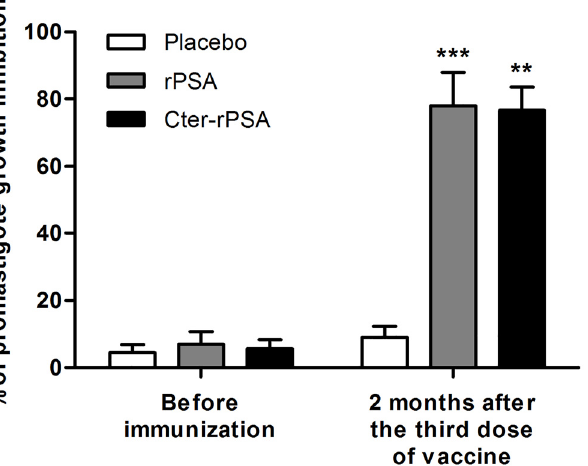
Fig 3. Effect of immunized dog sera on the proliferation of L . infantum promastigotes. The anti- proliferative effects were assessed on the growth of L . infantum promastigotes previously exposed for 30 min to serum samples from placebo (n = 5) and vaccinated dogs [rPSA (n = 9) or Cter-rPSA (n = 5)], collected before immunization and at 2 months post-vaccination, and then washed and cultured for 3 days at 25°C in 5 mL of RPMI medium supplemented with 20% foetal calf serum (FCS). At day 3, parasites were counted by flow cytometry (FACSCanto, Becton Dickinson) to assess cellular viability and parasite concentration. Results are expressed in percentage of promastigote growth inhibition +/- standard deviation ( * p < 0.05, ** p < 0.01, *** p < 0.001).